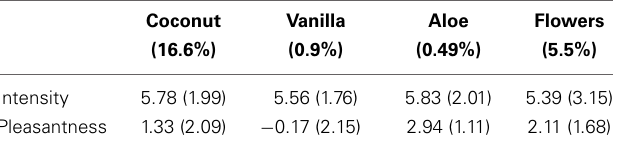
parentheses for concentrations similar in perceived intensity, but differing in perceived